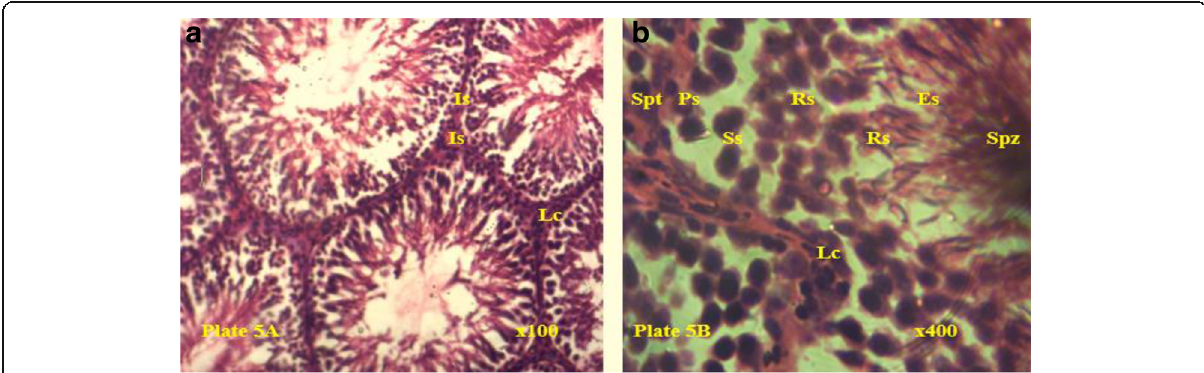
Fig. 9 a , b Photomicrograph of testes of group 3: Representative testicular micrograph of wistar rats given 100mg/kg/d of aluminum chloride and 2ml of pineapple juice (PJ) showing structure of normal seminiferous tubules. Ld Luminal Diameter, Lc Leydig cell, Spt spermatogonia, Ps primary spermatids, Ss Secondary spermatocytes, Es elongated spermatids, Rs Round spermatids, It Interstitial space, Spz spermatozoa. Stain is H&E and Magnification x 100 and x 400